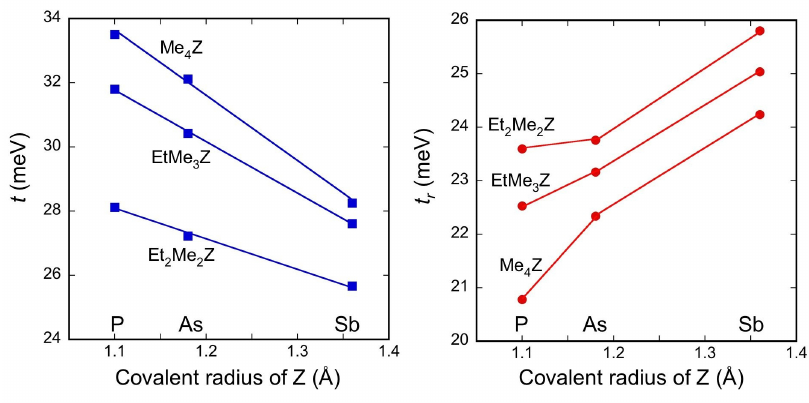
Figure 7. Relations between t